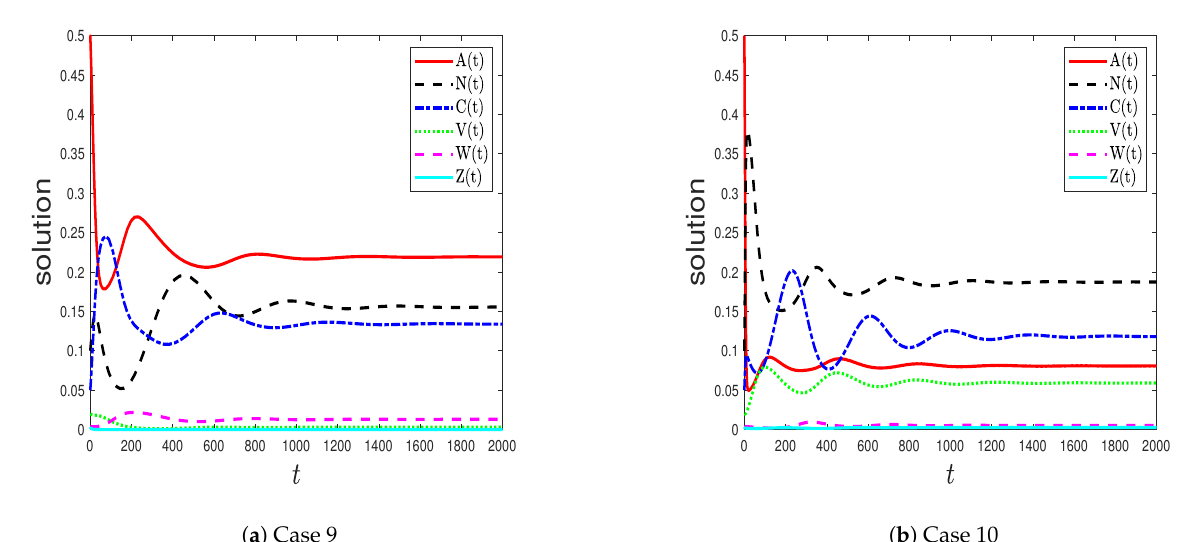
Figure 3. The numerical simulations of system (1) for cases 9 and 10. The figures exhibit the stability of ( a ) the antibody-free steady state E 8 : η 1 = 0.2, η 2 = 0.3, η 4 = 1.5, η 5 = 0.3, κ 1 = 0.01, κ 2 = 0.008, κ 3 = 0.0005, κ 4 = 0.0001, κ 5 = 0.07, and ( b ) the coexistence steady state E 9 : η 1 = 0.9, η 2 = 0.5, η 4 = 1.7, η 5 = 1.7, κ 1 = 0.0001, κ 2 = 0.0003, κ 3 = 0.0003, κ 4 = 0.0001, κ 5 = 0.0001.